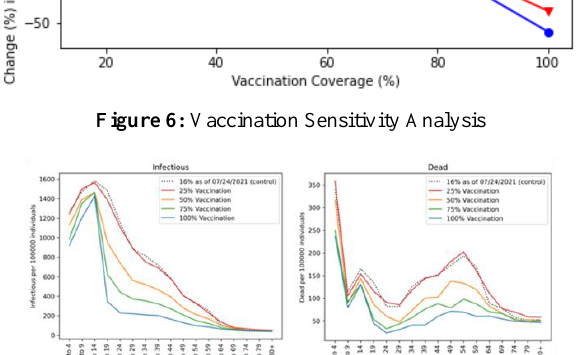
Figure 7. Age distribution of projected infections and deaths for Quezon City, Philippines under various vaccination scenarios.